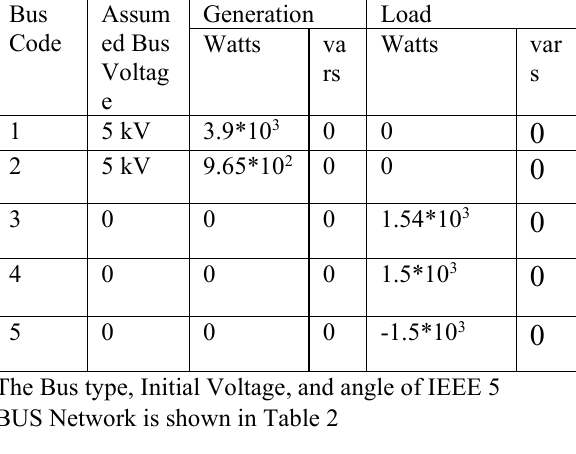
Table 2 Bus Type. Initial Voltage of IEEE 5 BUS System